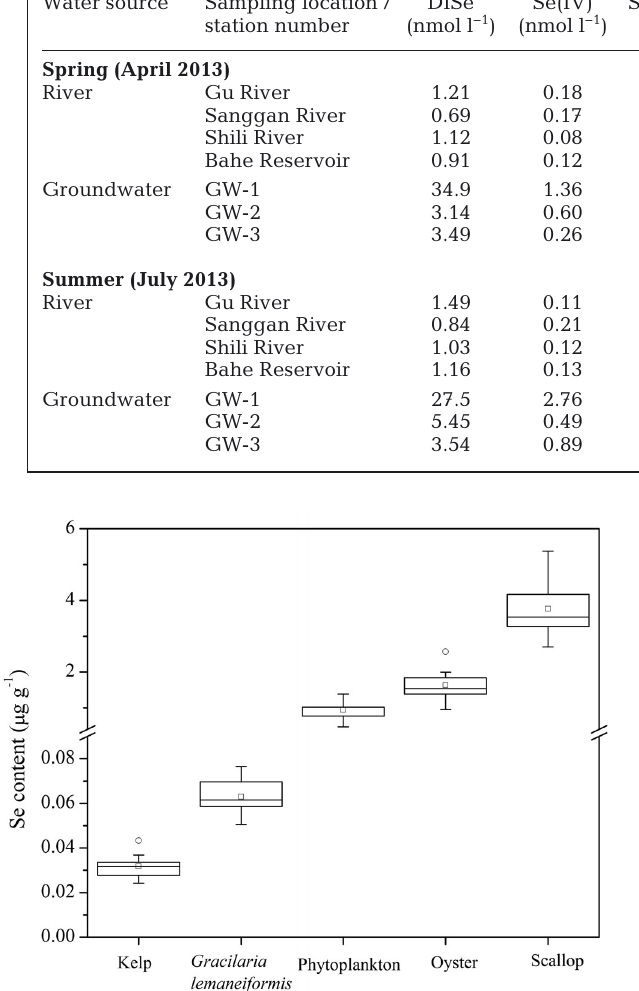
Fig. 4. Selenium (Se) content in kelp (n = 11), G. lemanei - formis (n = 9), phytoplankton (n = 6), oysters (n = 9) and scal- lops (n = 9). Box plot details as in Fig.